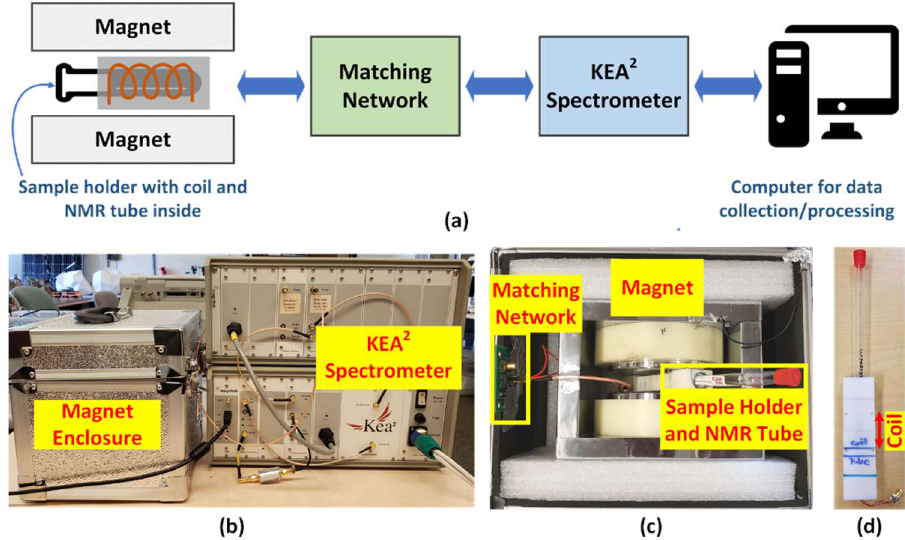
Figure 2. ( a ) A block diagram of the experimental setup; ( b ) a picture of the actual measurement setup; ( c ) an inside view of the magnet enclosure; and ( d ) a picture of the 3D-printed sample holder parts with the coil and an NMR tube